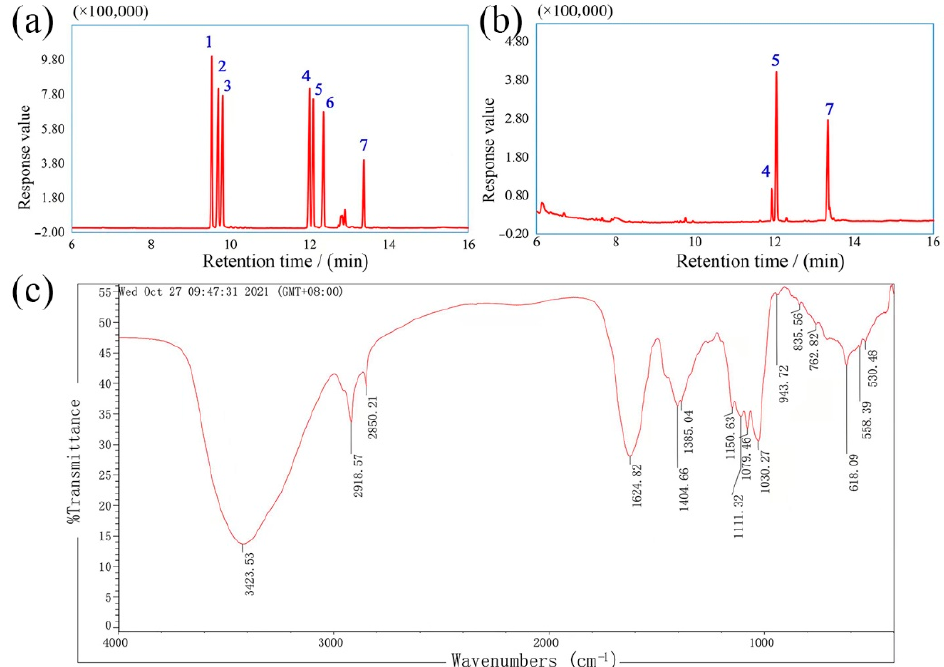
Figure 2. GC spectra of six monosaccharide standards ( a ) and DOPs ( b ) (Peaks identity: 1- L- rhamnose; 2- D-arabinose; 3- D-xylose; 4- D-mannose; 5- D-glucose; 6- D-galactose; 7- myo-inositol hexaacetate); FT-IR spectrum ( c ) of DOPs.